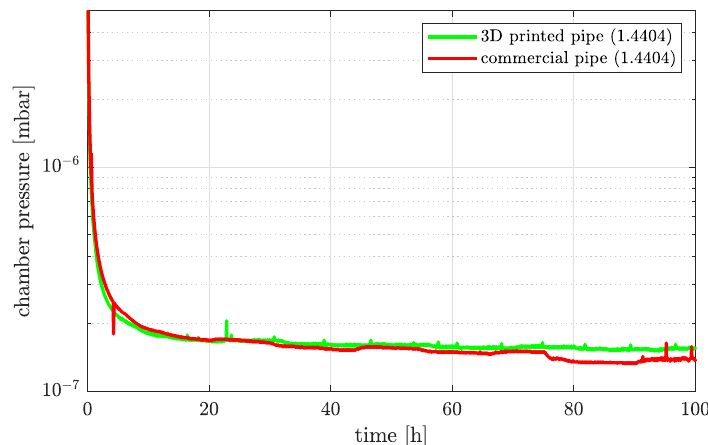
Figure 4. Pumpdown curve of the fourth vacuum cycle of the KF40 test pipes.